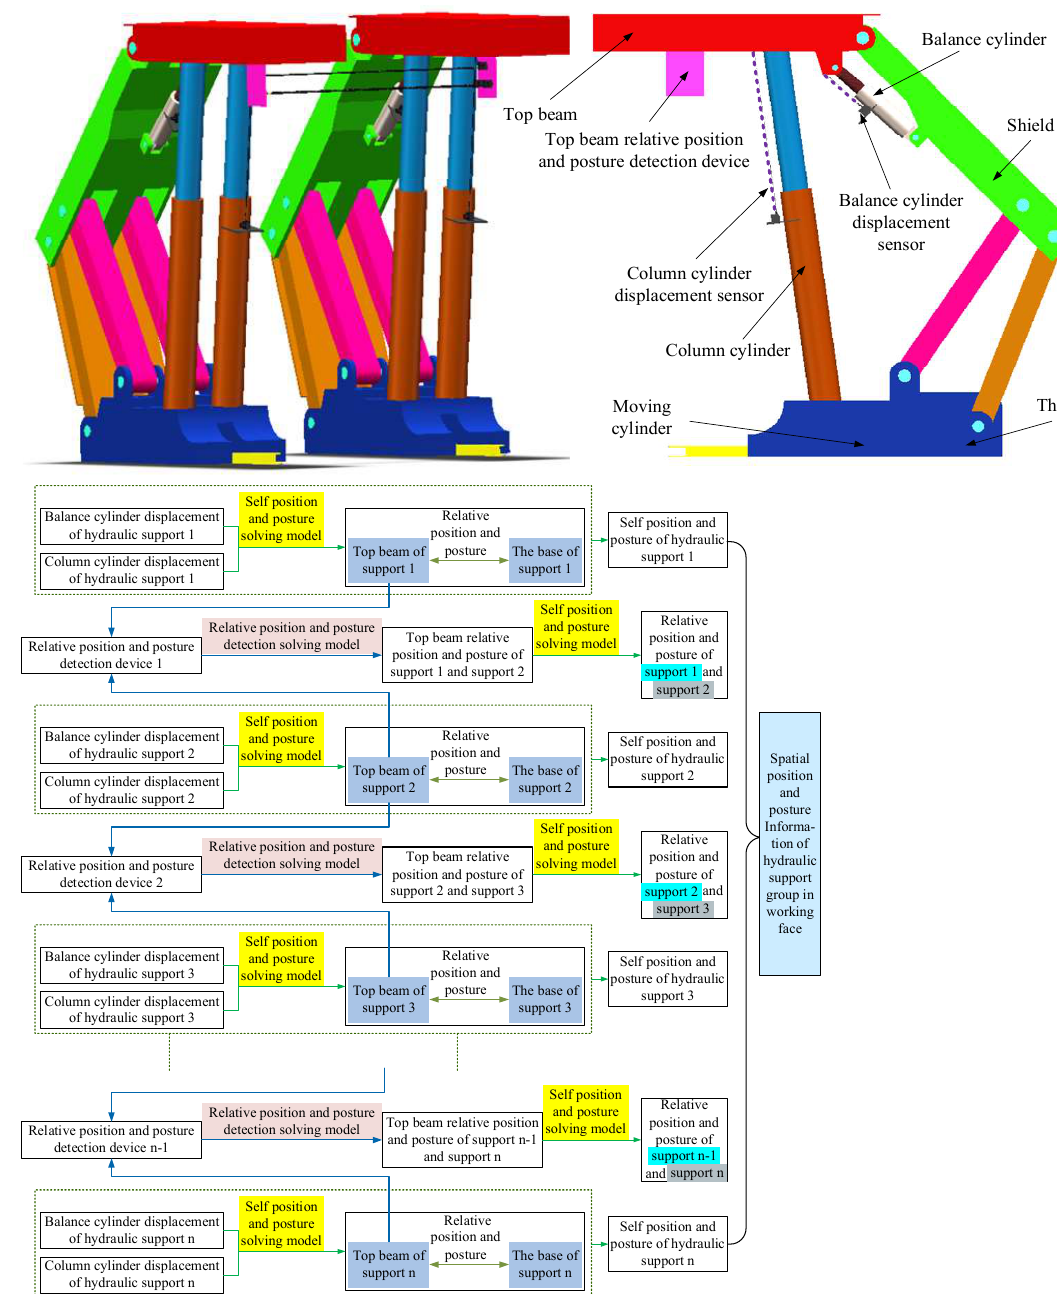
Figure 1. Schematic diagram of position and posture detection of hydraulic support group.